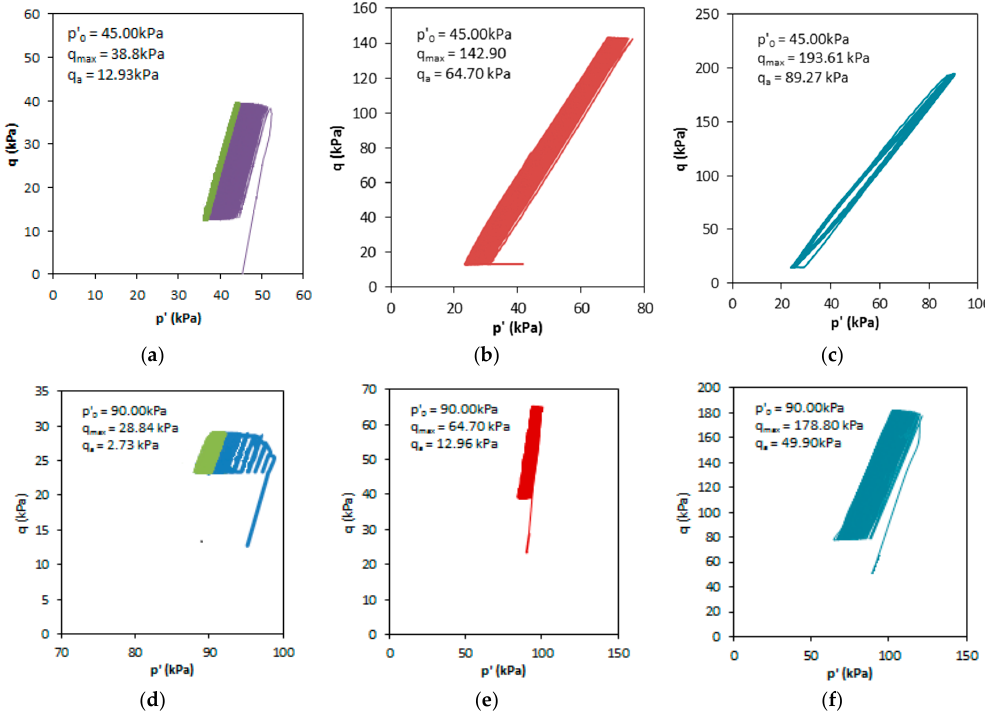
Figure 7. Stress paths for different test conditions: ( a ) 1.1; ( b ) 1.2; ( c ) 1.3; ( d ) 2.1; ( e ) 2.2 and ( f ) 2.3; as defined in Table 1.